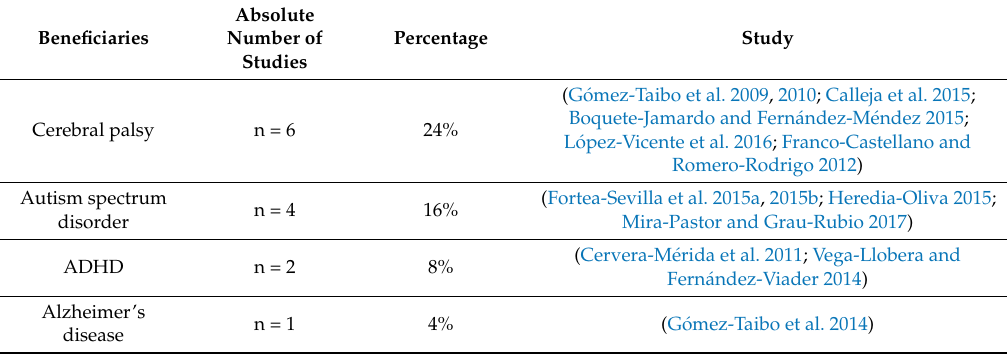
Table 1. Distribution of the studies according to the specific beneficiaries of the Systems of Augmentative and Alternative Communication (SAACs).